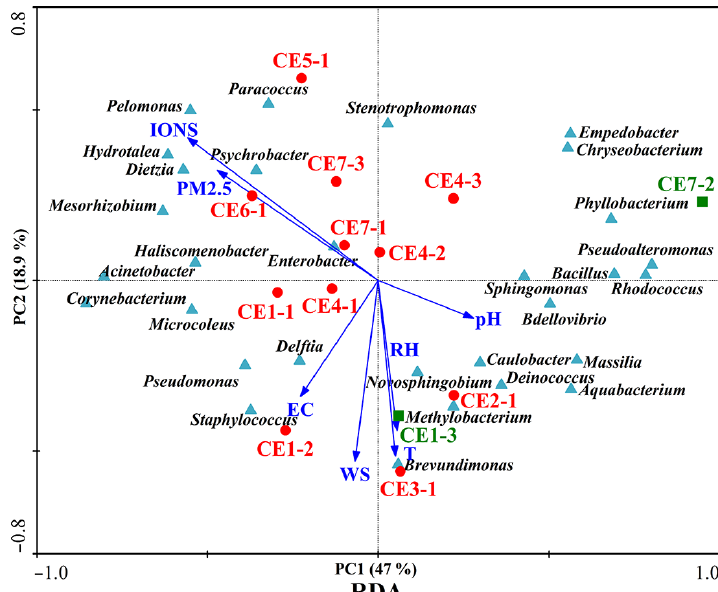
Figure 5. Biplot of the environmental variables and genus-level community structure using a redundancy analysis model (RDA), describing the variation in bacterial community explained by environmental variable. CE refers to cloud episodes. Polluted episodes are indicated by red circles, and non-polluted episodes are green squares. Species data are listed in Table S2. The selected environmental variables are significant ( p <0.05) using a Monte Carlo permutation test. Species are labeled with triangles. The closeness of these indicates correlation with each other and existence in similar environment. Environmental variables are showed by arrows; the relative length is positive correlation with the importance in influencing bacterial community structure. The angle between the arrow and the ordination axis suggests the variable response with respect to the RDA gradient. The two axes explain 65.9% of the variability. For bacteria, major ions in cloud water seem to be the crucial environmental variable in shaping community